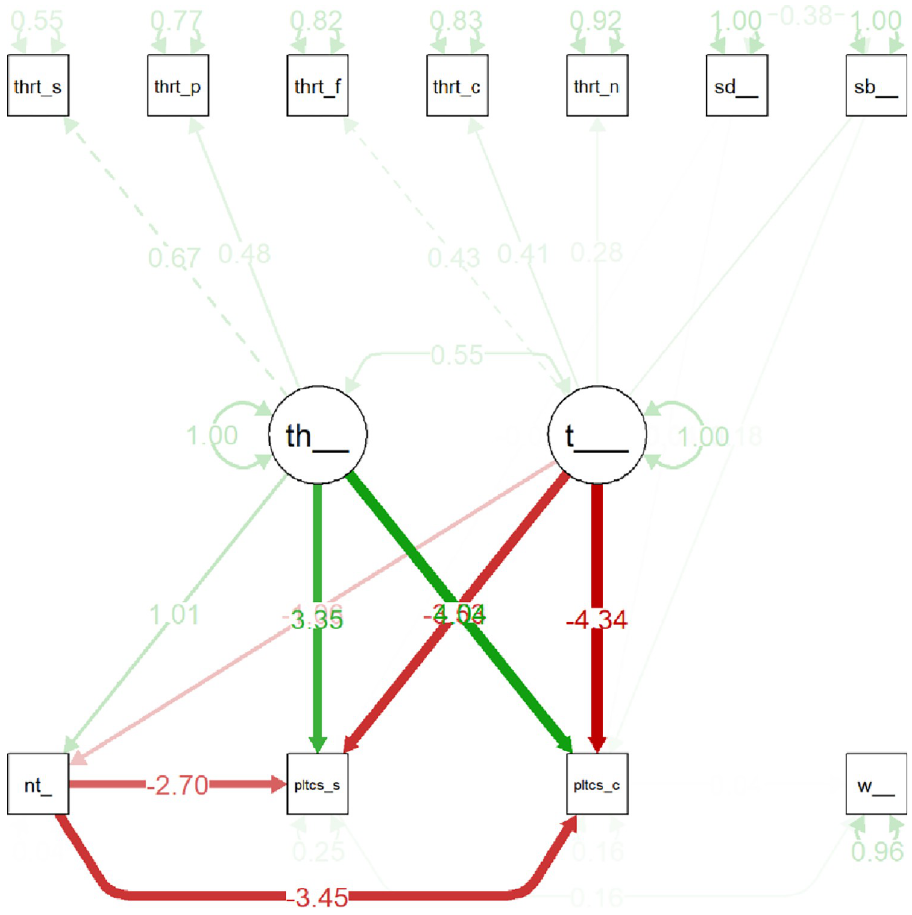
Fig 13. A plausible structural equation model explaining data trends to inform a system dynamics model of nationalism and political sentiment related to threats and supernatural beliefs.